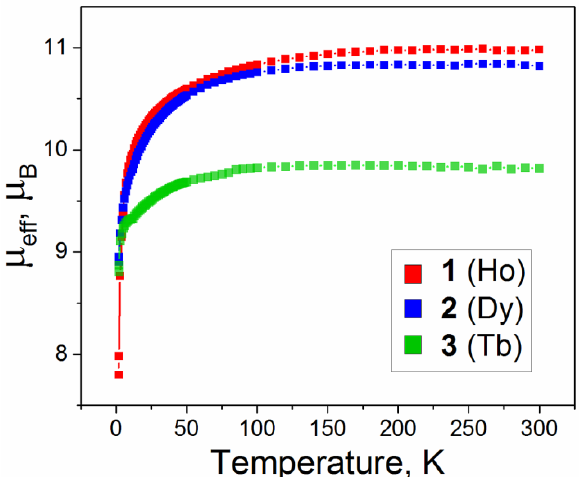
Figure 6. Temperature dependence of effective magnetic moment of 1 , 2 , and 3 . The effective magnetic moment is 10.98 µ B for 1 with holmium ( χ M T value is 15.07 emu · K/mol per formula unit), 10.81 µ B for 2 with dysprosium ( χ M T value is 14.65 emu · K/mol per formula unit), and 9.82 µ B for 3 with terbium ( χ M T value is 12.05 emu · K/mol per formula unit), respectively (Figure 6). These values are somewhat higher than expected for isolated Ho (III), Dy (III), and Tb (III) ions, which have